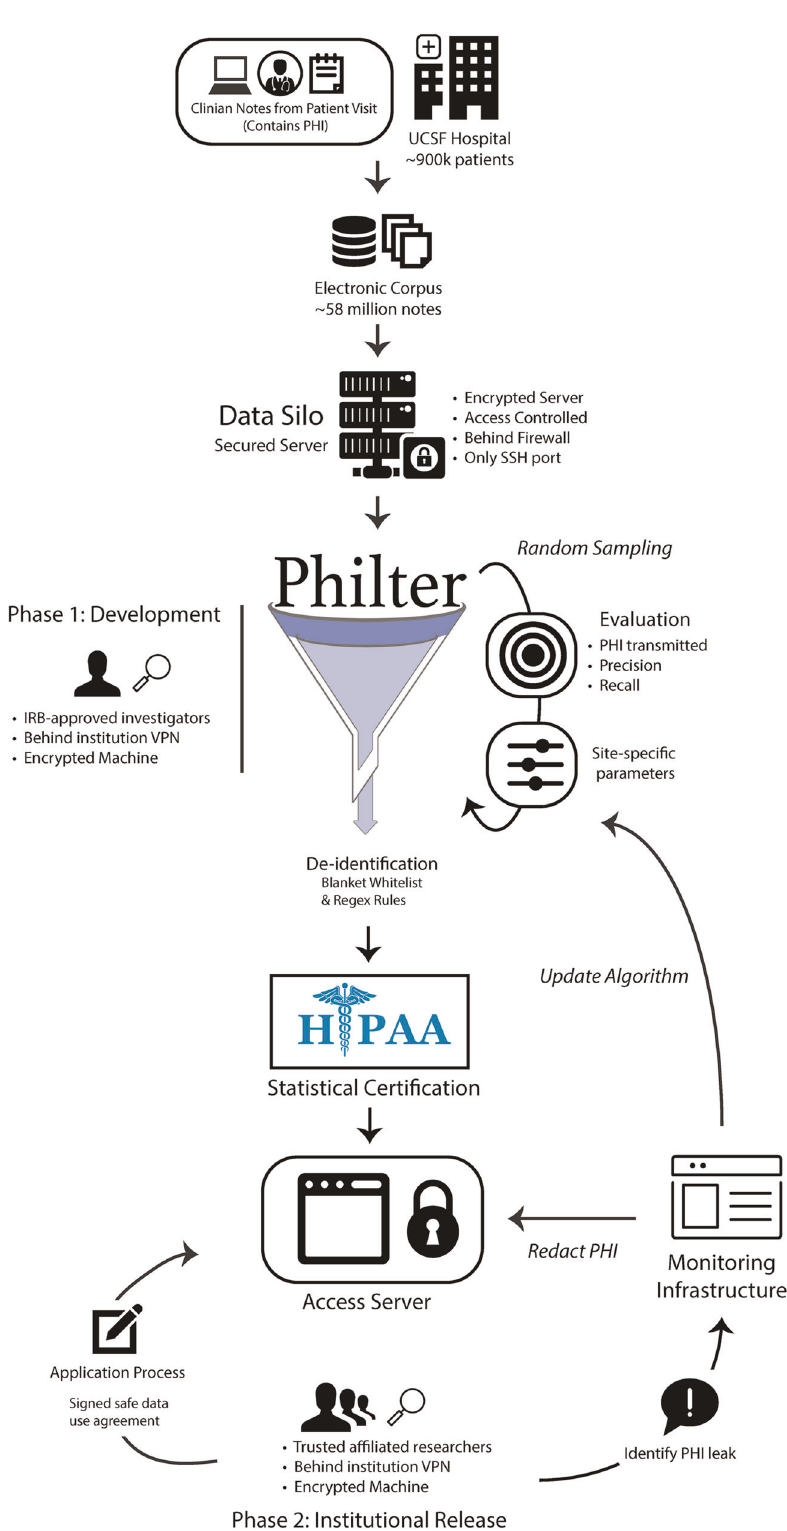
Fig. 2 Ecosystem. The compute environment and system used for the development and validation of